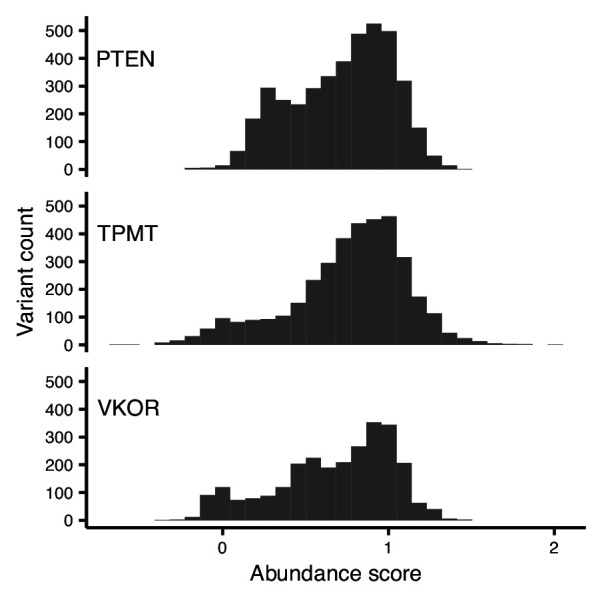
Trimodality of missense variant abundance scores is unique to VKOR.Histograms of abundance scores for missense variants for three proteins: PTEN, TPMT, and VKOR.